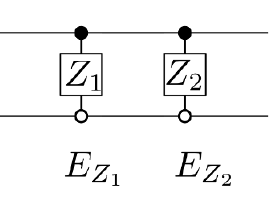
= E Z E Z of two transfer operators. Left-multiplication by an 1 (cid:10) Z 2 1 2